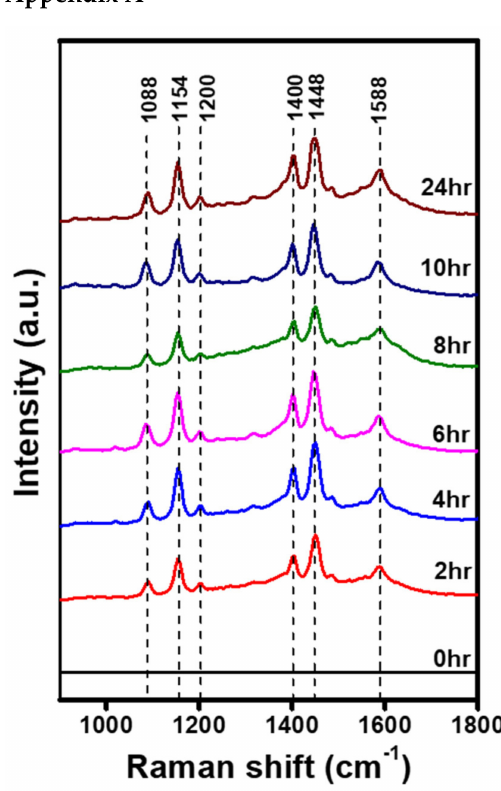
Figure A1. SERS spectra of 4-ATP acquired on Ag/PDA/CaO substrates prepared under different Ag-NPs deposition times (0, 2, 4, 6, 8, 10 and 24